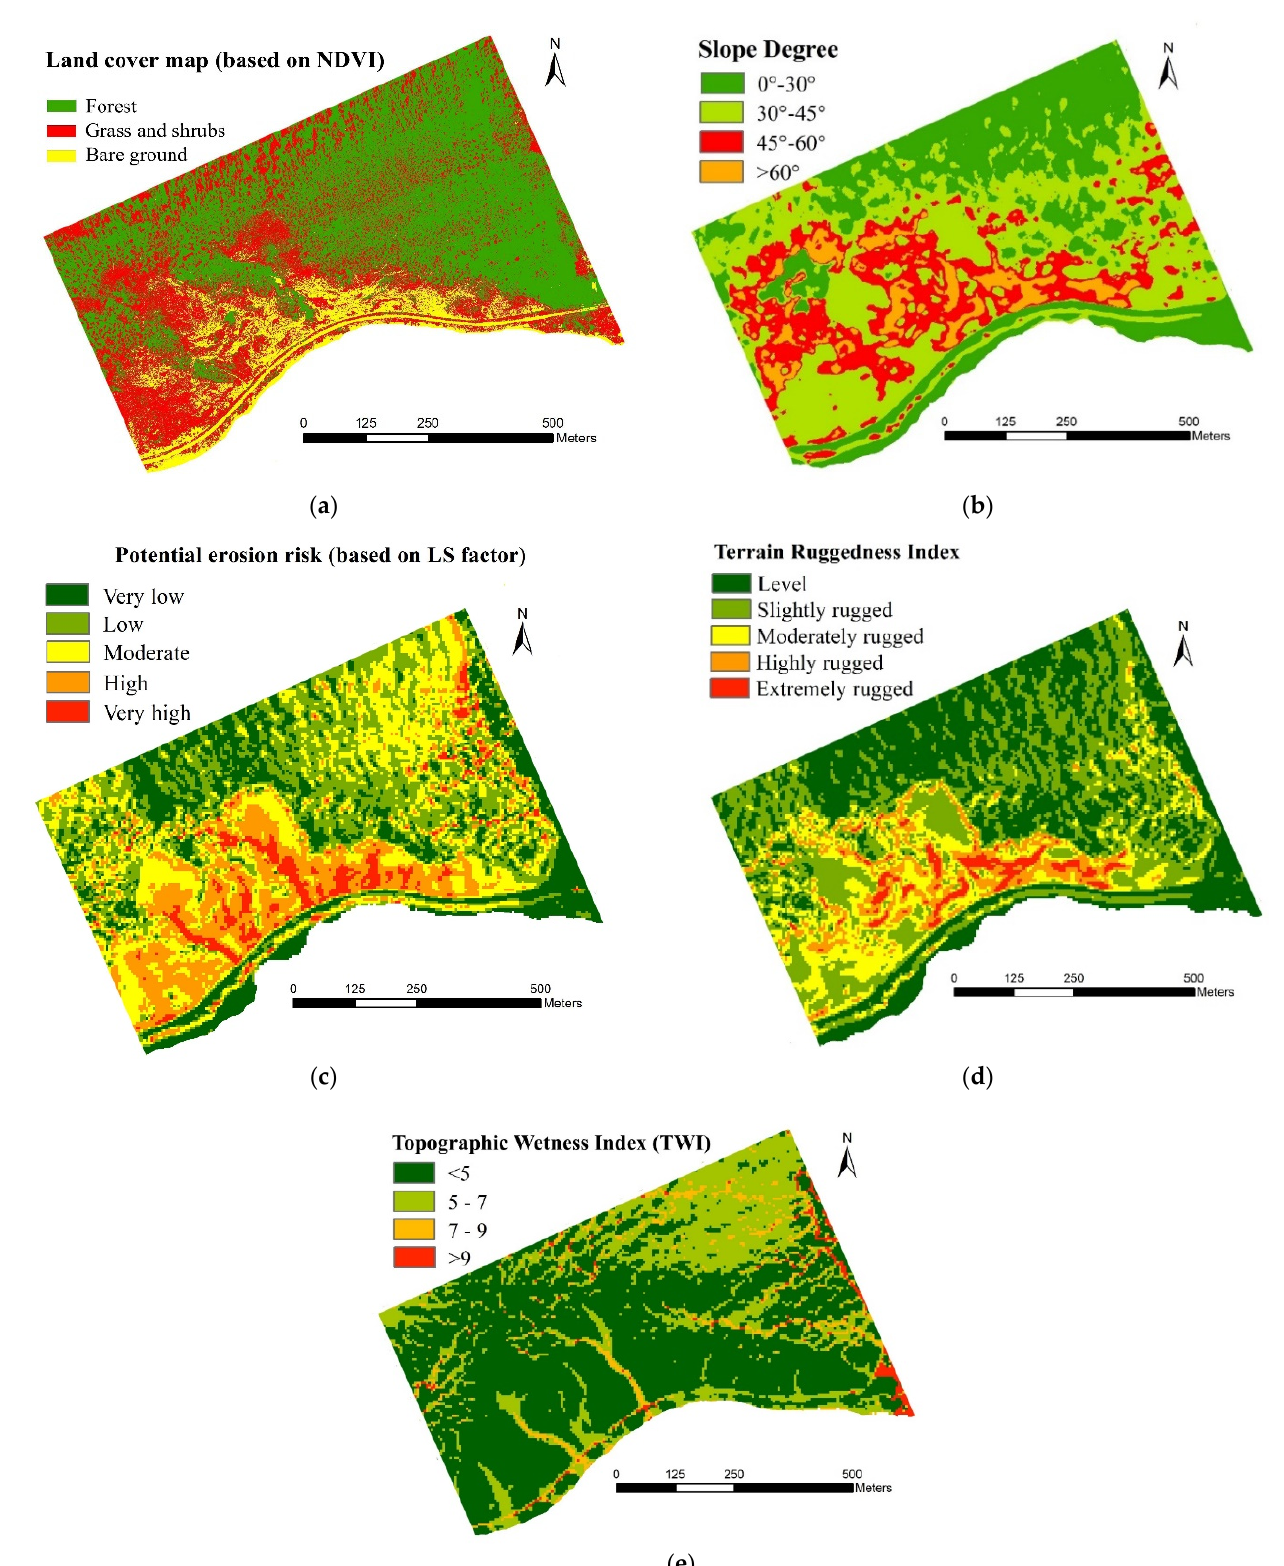
Figure 8. Conditioning factor maps: ( a ) land cover map; ( b ) slope angle map; ( c ) LSF map; ( d ) TRI map; ( e ) TWI map.